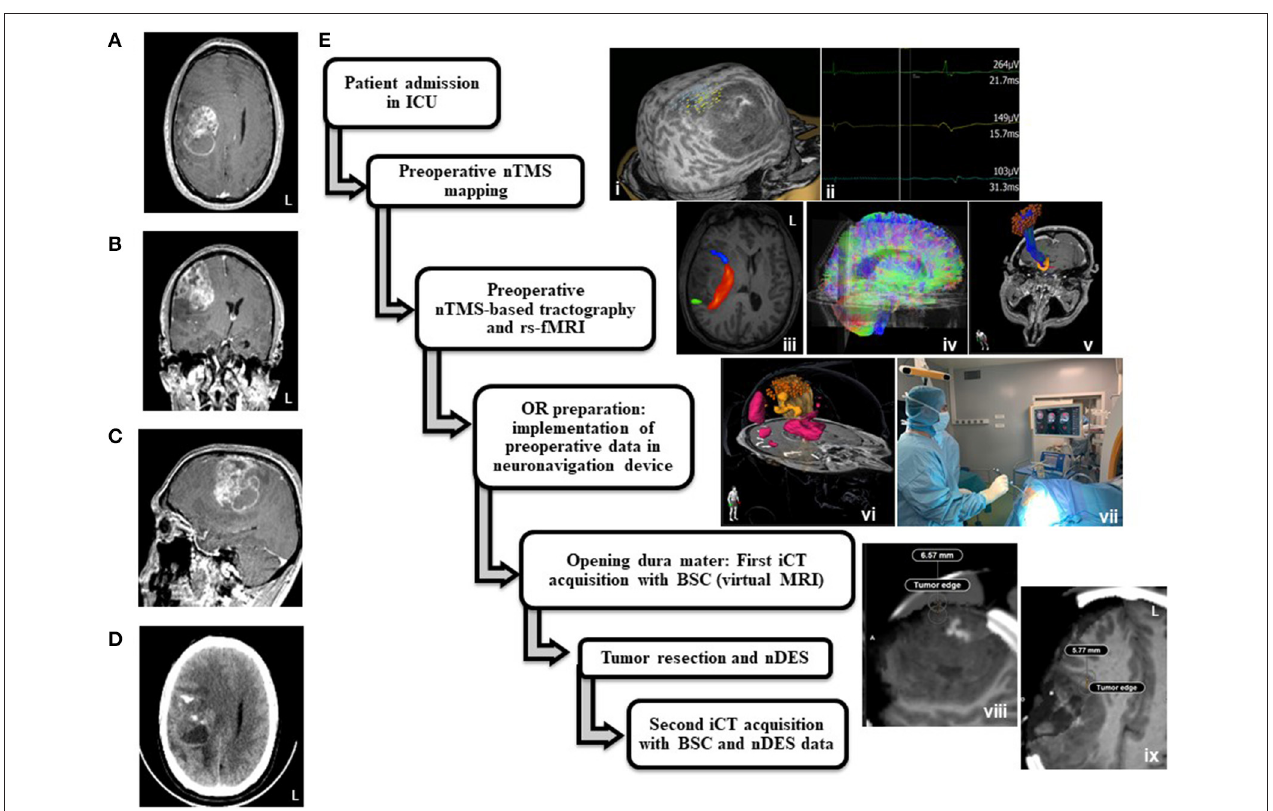
FIGURE 1 | Medicosurgical management of the left-handed patient. Preoperative brain Magnetic Resonance Imaging (MRI): axial (A) , coronal (B) , and sagittal (C) slices of T1 weighted imaging after gadolinium intravenous injection, showing a frontal precentral right mass with heterogeneous contrast uptake and necrosis. Axial slice of Preoperative brain computerized tomography (D) showing intratumoral calcifications. Application of the “M-iCT BSC” procedure in this presented case (E) . i: navigated transcranial magnetic stimulation (nTMS) preoperative mapping (left panel) and Motor Evoked Responses examples (right panel) at 55% MSO for the TA (blue dots) and deltoid (yellow dots) muscles, and 81% for FID (green dots), ii: motor nTMS evoked potentials, iii: resting state functional MRI (rs-fMRI) region of interest (ROI) for right anterior speech network (blue), rs-fMRI ROI for right posterior speech network (green), arcuate/superior longitudinal fasciculus anatomical tractography reconstruction, iv: whole brain tractograms, v: motor nTMS-guided functional tractography, vi: 3D implementation of nTMS-guided motor tractography (yellow streamlines), anatomical speech tracts (white streamlines), motor rs-fMRI (orange ROI), speech rs-fMRI (pink ROI) and motor positive points for nTMS (orange dots). vii: Neuronavigation device, intraoperative monitoring device and intraoperative CT scan. viii: Axial slice of iCT the first intraoperative brain CT (iCT) acquisition with virtual MRI and brain shift correction (BSC). ix: Axial slice of second iCT acquisition with virtual MRI and BSC halfway through